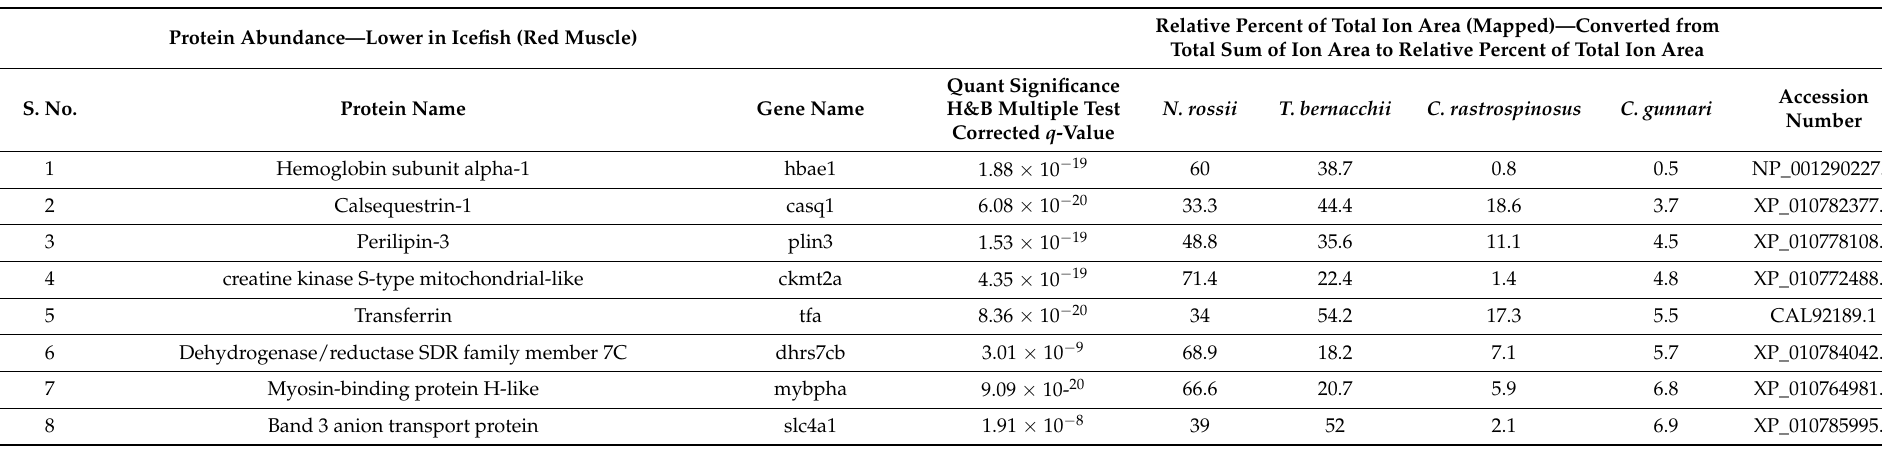
Table 3. DEPs in RMM with decreased abundance in icefish specifically seen downregulated in icefish Champsocephalus gunnari . Protein Abundance—Lower in Icefish (Red